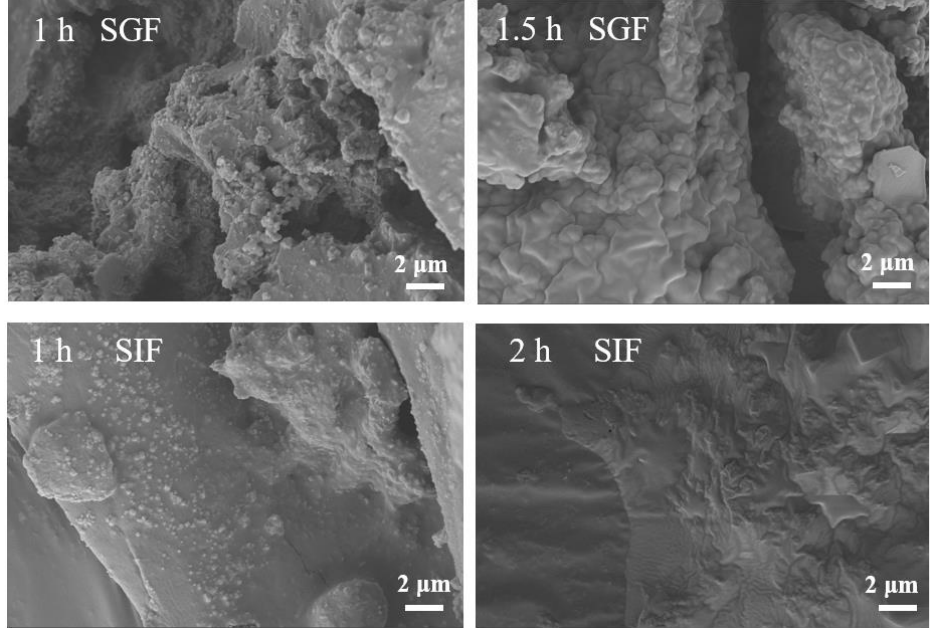
Figure 9. SEM images of E-Z/G 1:1 complex nanoparticles in simulated gastric fluid (SGF) and simulated intestinal fluid